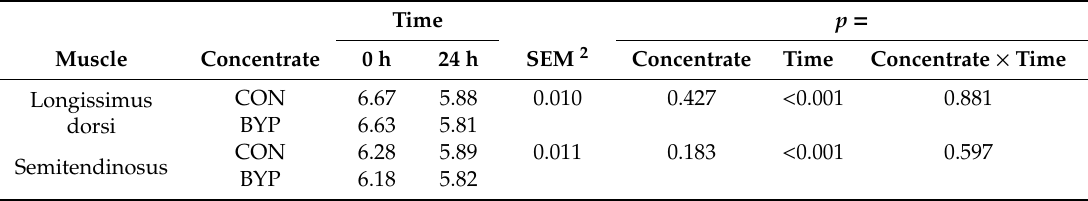
Table 2. Values of pH of longissimus dorsi and semitendinosus muscles at 0 and 24 h post-slaughter in fattening light lambs fed either a high-cereal concentrate (CON) or a concentrate including by-products (BYP) 1